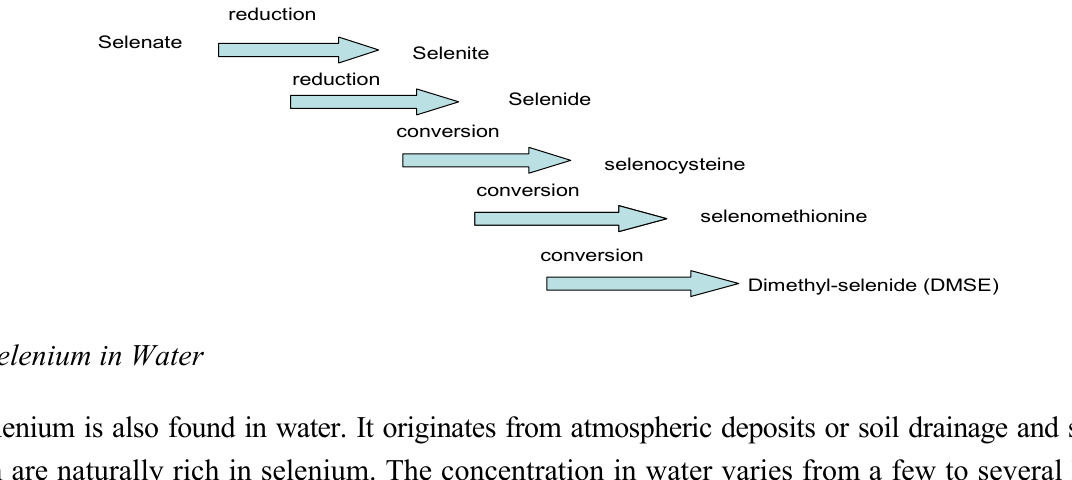
Figure 2. Formation of dimethyl-selenide [(CH3)